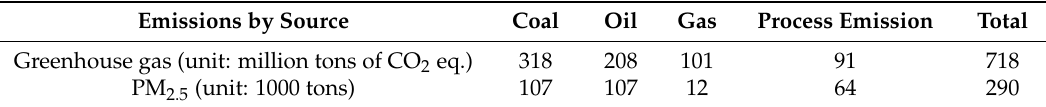
Table 3. Greenhouse gas and PM 2.5 emissions by